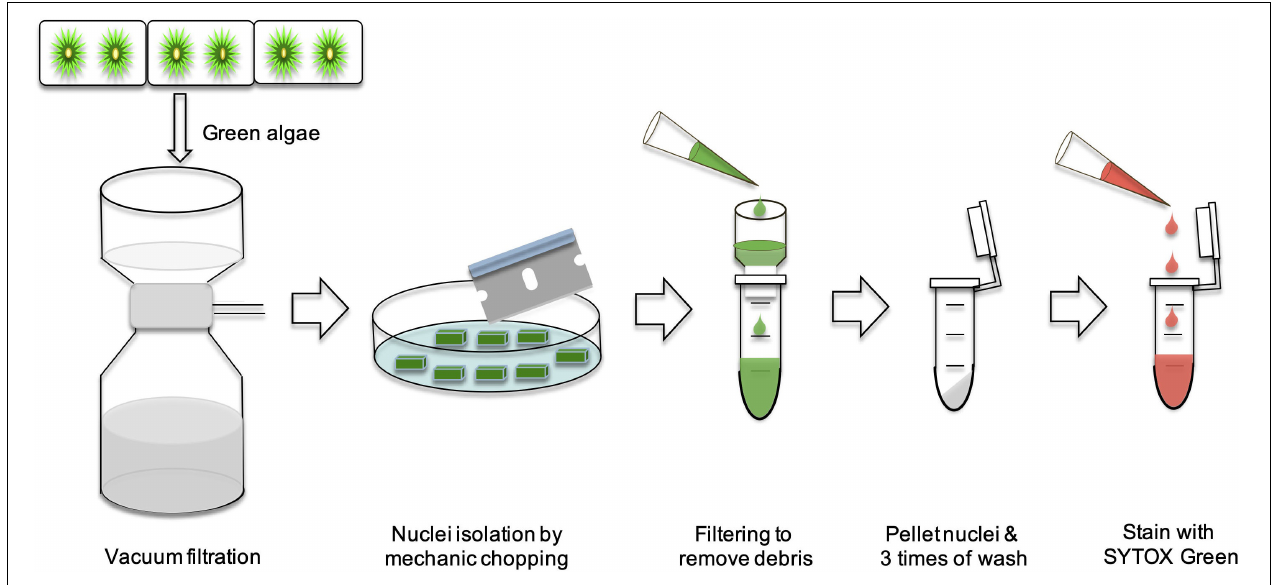
FIGURE 8 | Schematic diagram of Flow cytometry analysis in SAG 698-1a and SAG 698-1b.